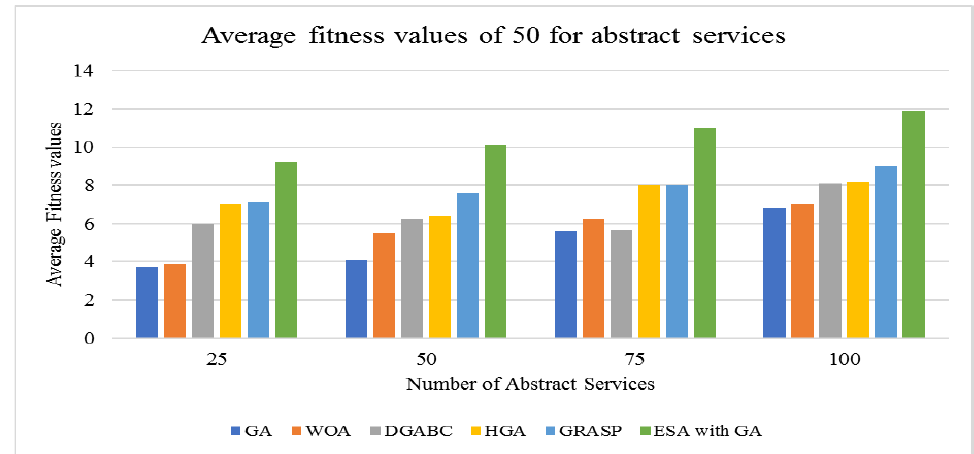
Figure 13. Best average fitness values for 50 abstract services.